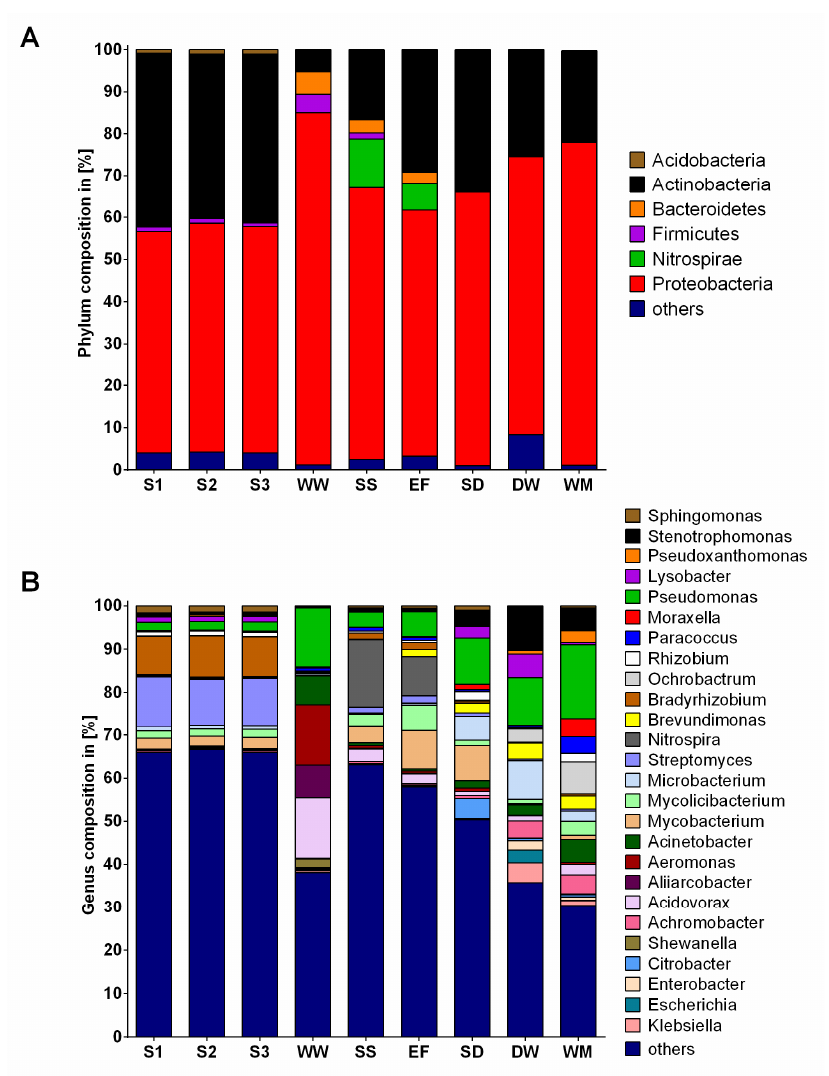
Figure 3. Bacterial composition at phylum ( A ) and genus ( B ) level of different soils (S1, S2, S3, each n = 4), wastewater (WW, n = 4), sewage sludge (SS, n = 4), WWTP effluent (EF, n = 4), shower drains (SD, n = 1), dishwashers (DW, n = 1) and washing machines (WM, n = 4) based on next generation sequencing. To ameliorate presentation, only phyla with ≥ 1% and genera with ≥ 2% in at least one sample group are shown.